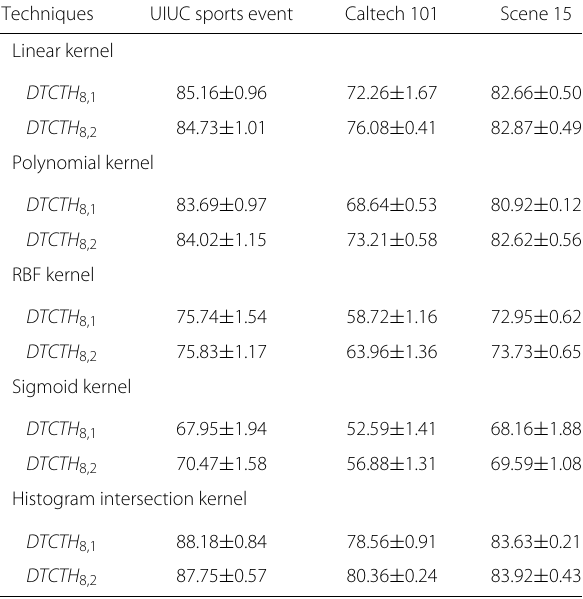
Table 2 Effect of different SVM and DTCTH parameters on UIUC Sports Event, Caltech 101, and Scene 15